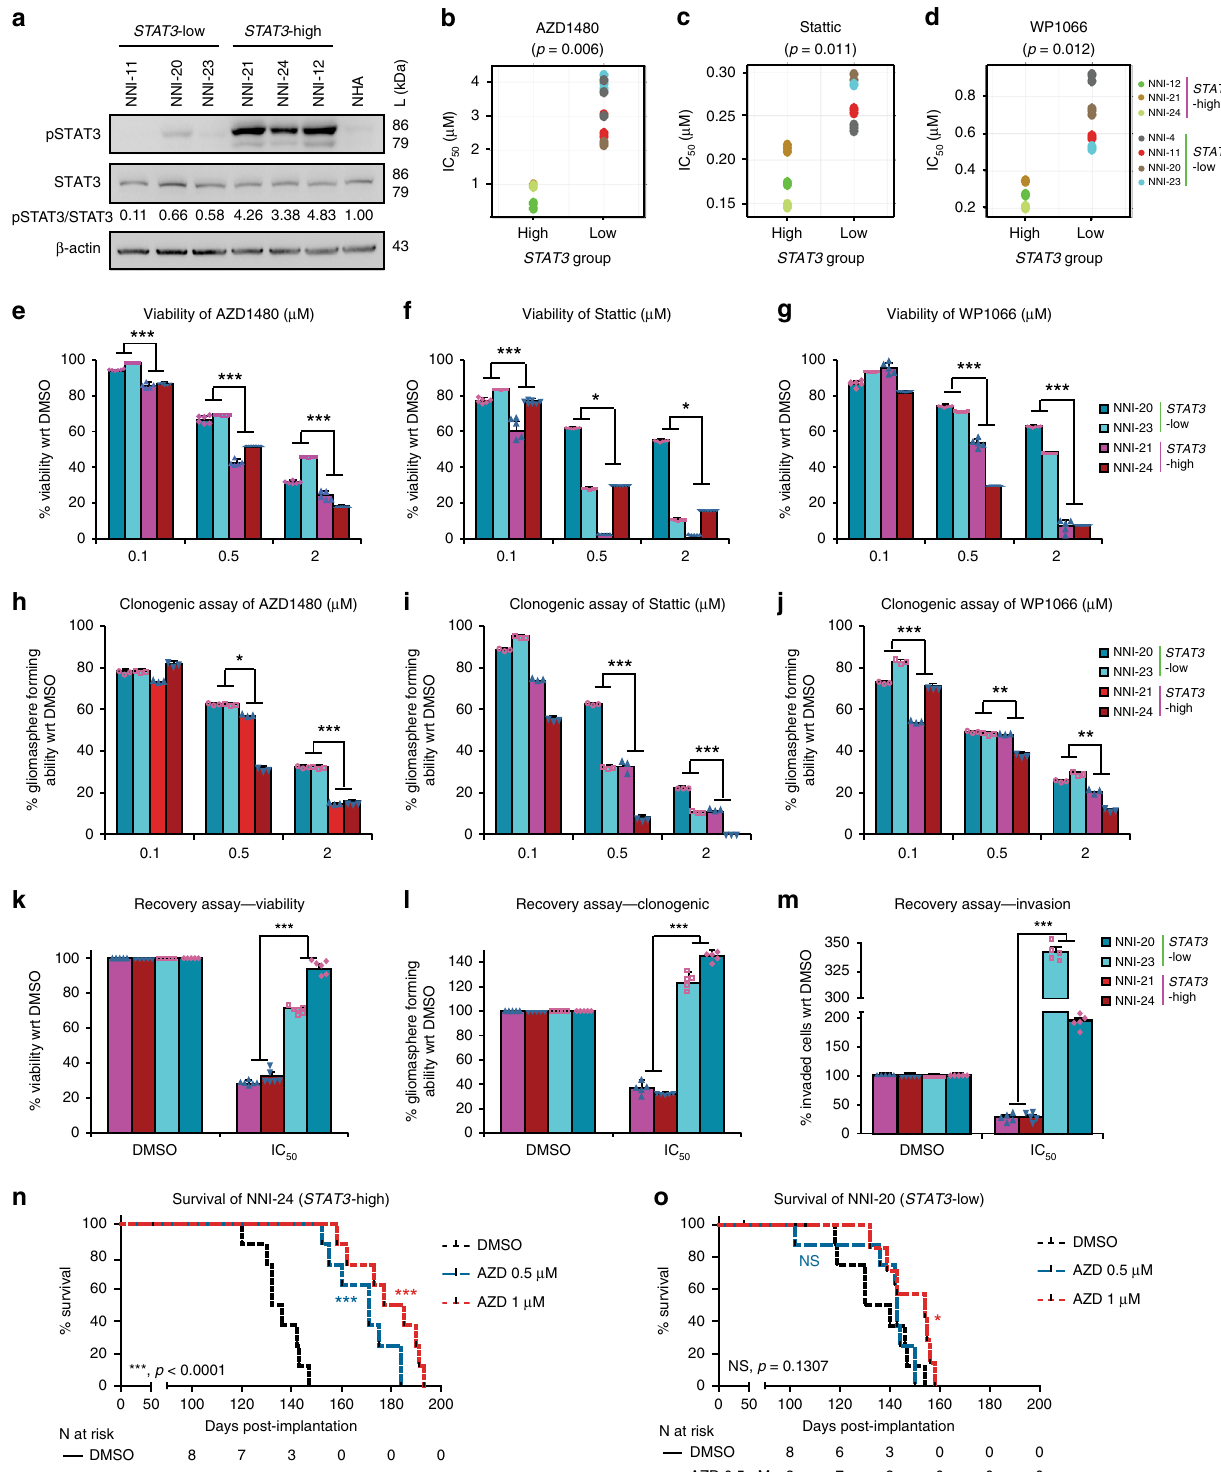
Inhibition of STAT3 and IGF-1R sensitizes STAT3 -low cells . We fi rst attenuated IGF-1R signaling pathway by targeting its effector, IGFBP2 , using lentiviral-mediated short hairpin RNA (shRNA) KD (NNI-20, Fig. 4a – c; NNI-23, Supplementary Fig. 5a – c). KD of IGFBP2 , resulting in IGFBP2 protein reduction, signi fi cantly sensitized STAT3 -low cells to STAT3 inhibitor